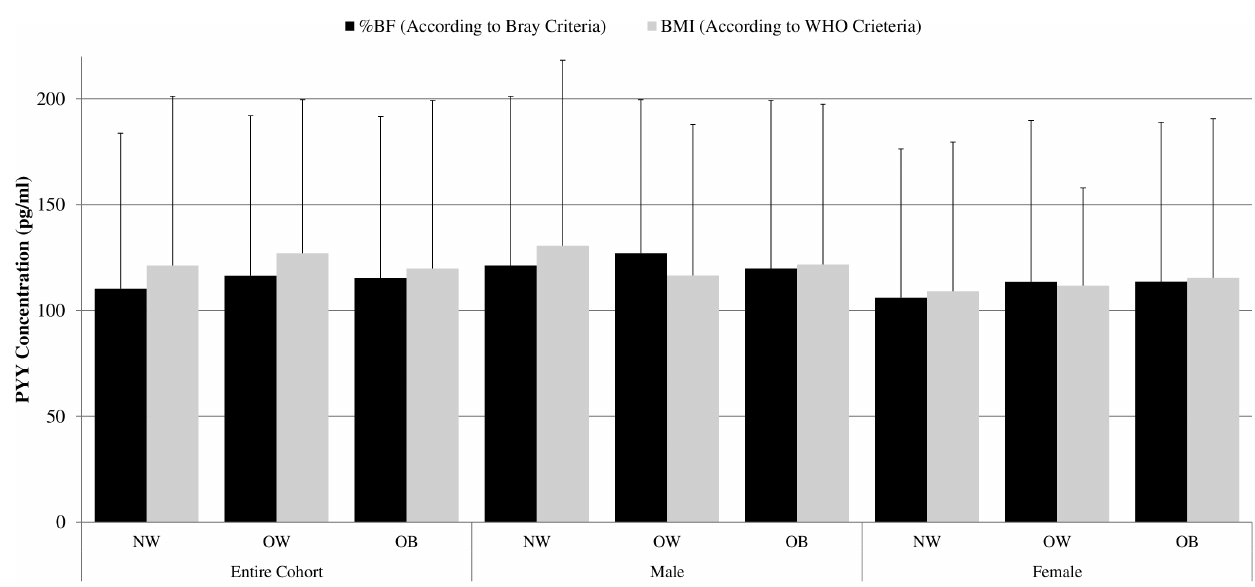
Figure 1. Fasting serum PYY among normal-weight, overweight and obese males and females. Fasting PYY concentration was not significantly different between normal-weight (NW), overweight (OW) or obese (OB) subjects defined either by body mass index (BMI) according to the WHO criteria [28] or percent body fat (%BF) measured by dual-energy x-ray absorptiometry (DXA) according to the Bray criteria [27]. Fasting PYY concentration was also not significantly different among adiposity groups among men and women